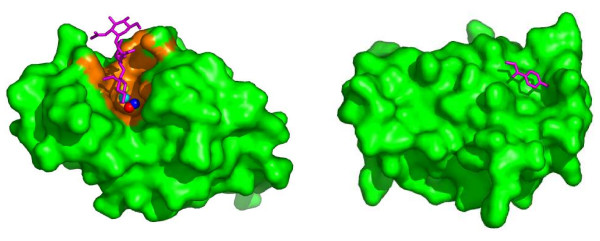
Left: Hen egg-white lysozyme with its ligand Tri-N-Acetylchitotriose (PDB 1hel). The ligand binds in a deep pocket and all algorithms correctly predict the binding site. red: LIGSITEcsc, blue: LIGSITE, cyan: PASS, yellow: SURFNET, orange: CAST. Right: Hexameric insulin with its ligand methylparaben (PDB 6ins). The binding site of the ligand is unusually flat and therefore none of the methods detects it correctly.